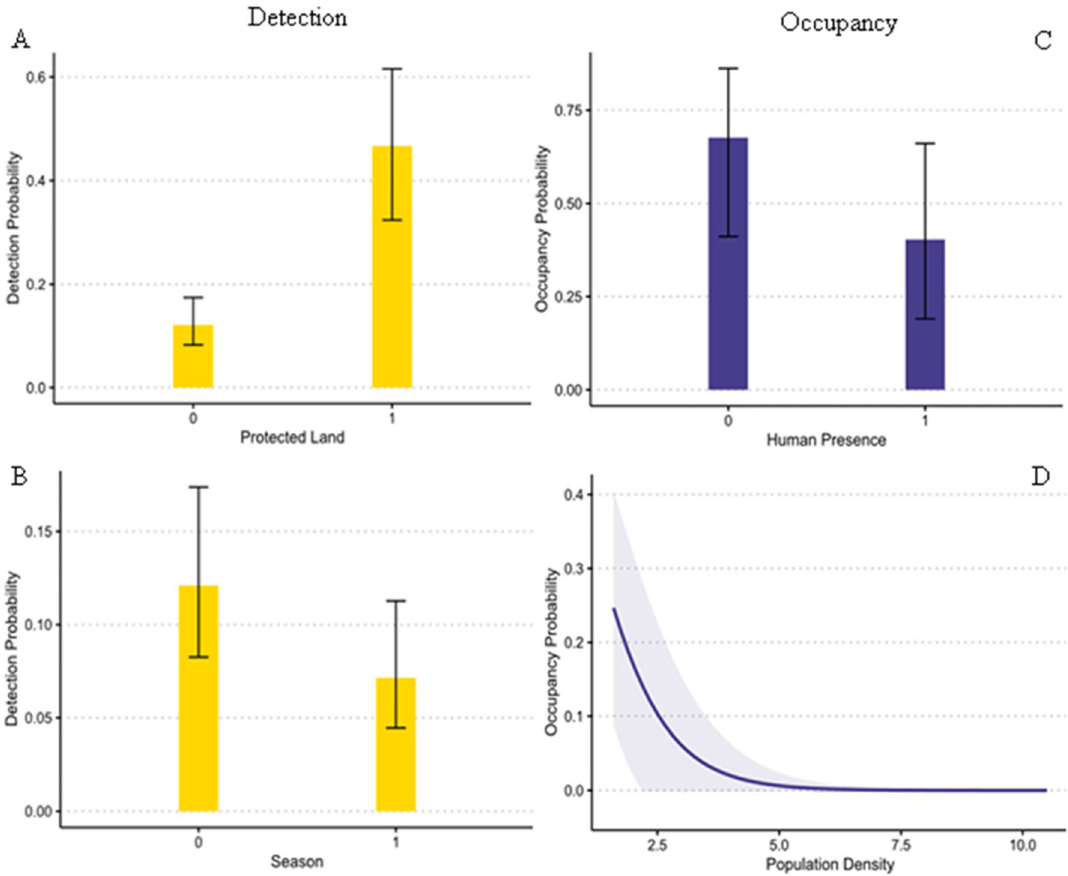
Figure 4. Top occupancy model results for detection and occupancy probability. Graphs in left column show the relationship between estimated detection probability and ( a ) protected land [0-unprotected, 1-protected], and ( b ) season [0-before hibernation, 1-after hibernation]. Graphs in right column show the relationship between estimated occupancy probability and ( c ) human presence [0-not present, 1-present], and ( d ) human population density. Shaded region represents the standard